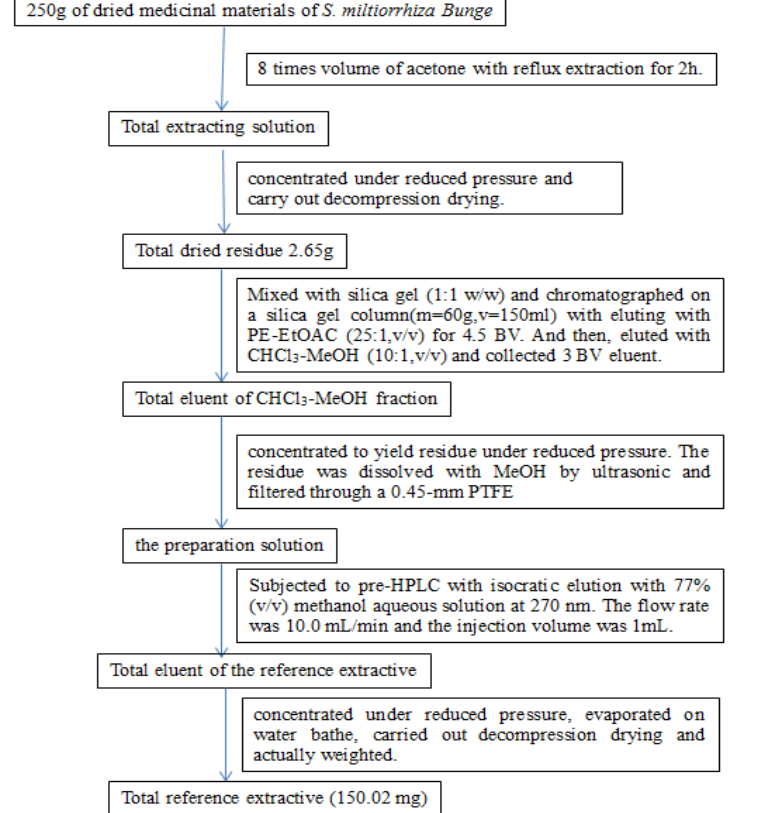
Figure 2. Total technological process of the reference extractive of S. miltiorrhiza